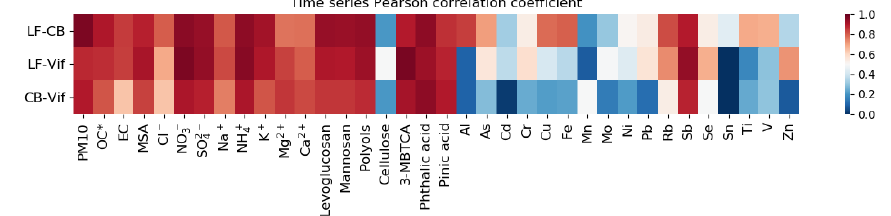
Figure 3. Concentration time series Pearson correlation coefficient of PM 10 and its chemical composition between LF and CB (LF-CB), LF and Vif (LF-Vif), and CB and Vif